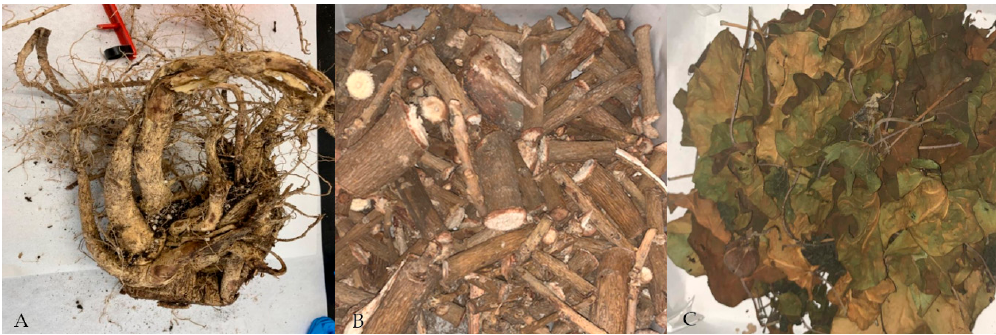
Figure 9. J. curcas L. ( A ) roots ( B ) stems and ( C ) leaves.